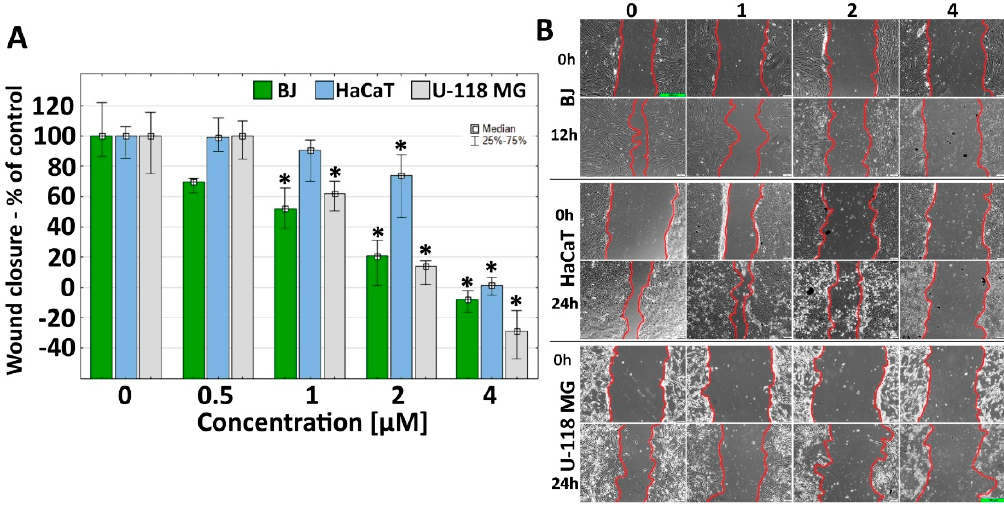
Figure 7. G3-BCL effect on BJ, HaCaT, and U-118 MG cell migration after 12 and 24 h treatment. Figure 7. ( A ) G3-BCL e ff ect on BJ, HaCaT, and U-118 MG cell migration after 12 and 24 h treatment. Results are presented as median of triplicate from three independent experiments and expressed as % of non-treated controls. The whiskers are lower (25%) and upper (75%) quartile ranges. * P < 0.05; (Kruskal–Wallis test). ( B ) Images from contrast-phase inverted microscope. Scale bar equal to 300 µ